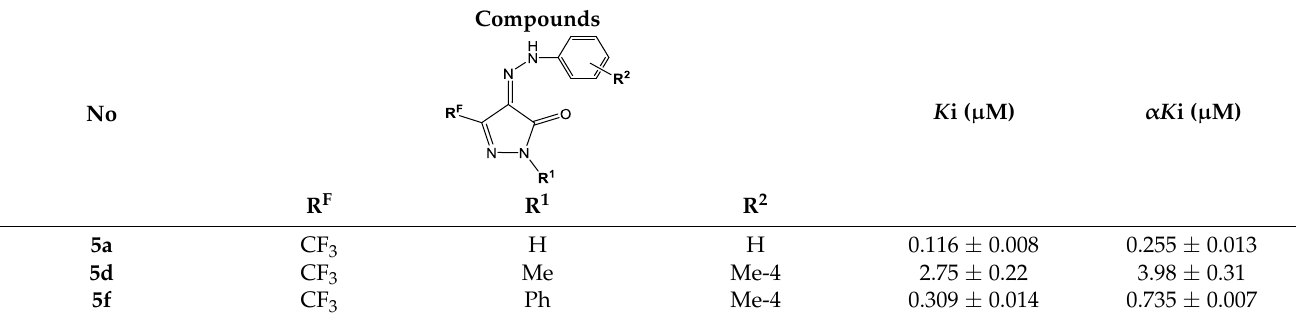
Table 4. CES inhibition constants for 4-AHPs 5a,d,f 1 .